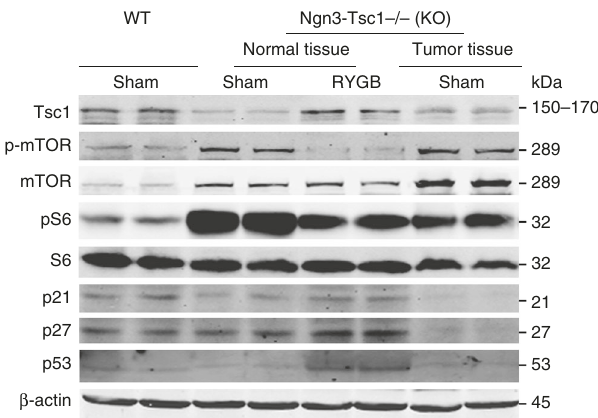
Fig. 4 Alteration in mTOR signaling and apoptotic proteins. mTOR signaling molecules such as Tsc1, phospho-mTOR (p-mTOR), mTOR, phospho-S6 (pS6), S6, as well as apoptotic proteins including p21, p27, p53 in normal and tumor pancreatic tissues were examined by western blotting using speci fi c antibodies. n = 2 for each condition, repeat two times